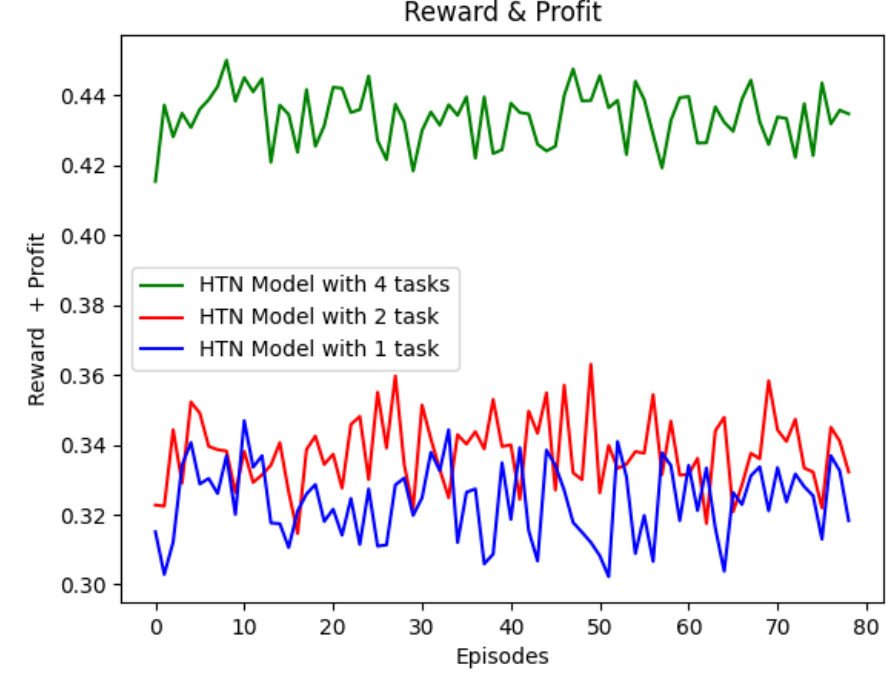
Figure 5. Results for different